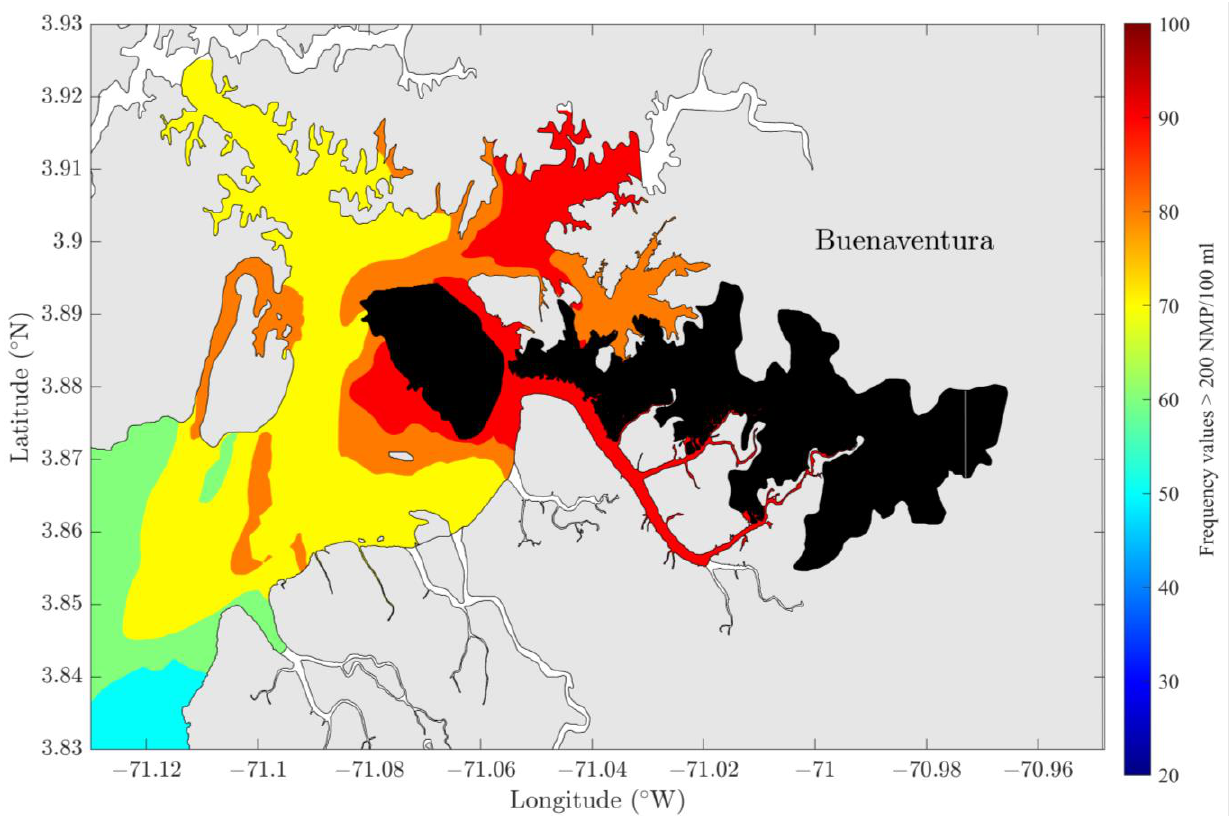
Figure 18. Exceeding frequency in areas affected by concentrations higher than 200 MPN/100 mL in scenario four; the inner part of Buenaventura Bay.